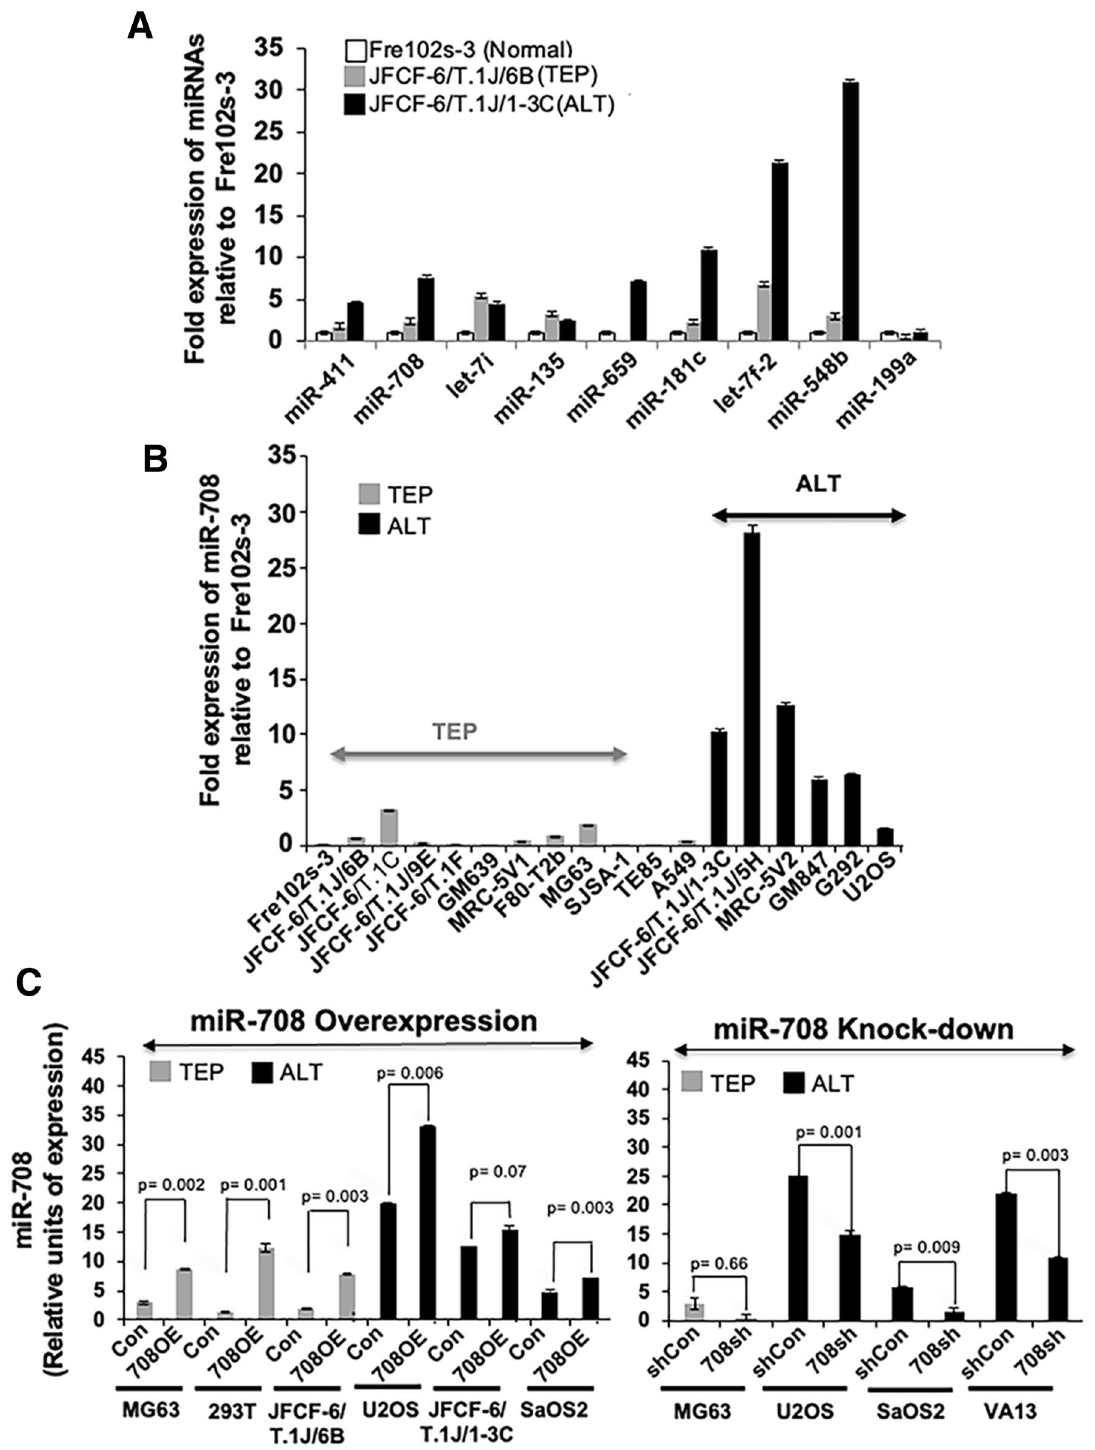
Figure 1. Identification of miRNAs differentially expressed in TEP and ALT cells. ( A ) Quantitative real-time PCR (qPCR) validation of the differentially expressed nine miRNAs that showed at least fivefold difference in expression in the miRNA array between isogenic TEP (JFCF-6/T.1J/6B) and ALT (JFCF-6/T.1J/1-3C) cells. ( B ) Comparison of miR-708 levels between various TEP and ALT cells by qPCR. miRNA expression is shown as fold expression as compared to control, normal (Fre102s-3) cells. The bars depicting normal cells are shown in white, TEP cells are shown in grey, and ALT cells are shown in black. Data represent mean ± SD (n = 3). A variety of TEP and ALT cells were used for miR-708 overexpression and knockdown of miR-708. ( C ) qPCR for miR-708 was performed in control, miR-708-overexpressing, and miR-708-deficient TEP and ALT cells. Data represent mean ± SD (n = 3). Con: control for miR-708 expression; 708OE: miR-708 expression; shCon: control for miR-708 knock-down; 708sh: miR- 708 knock-down using short-hairpin interfering RNA. p < 0.05 was considered as statistically